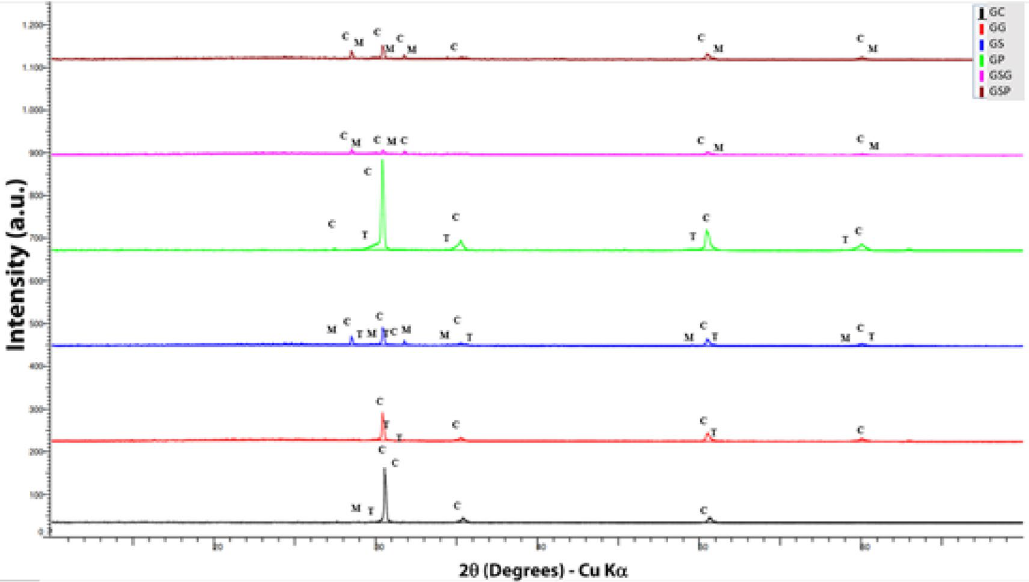
Figure 2. Diffractograms obtained from 5Y-PSZ bars submitted to staining and/or surface finishing